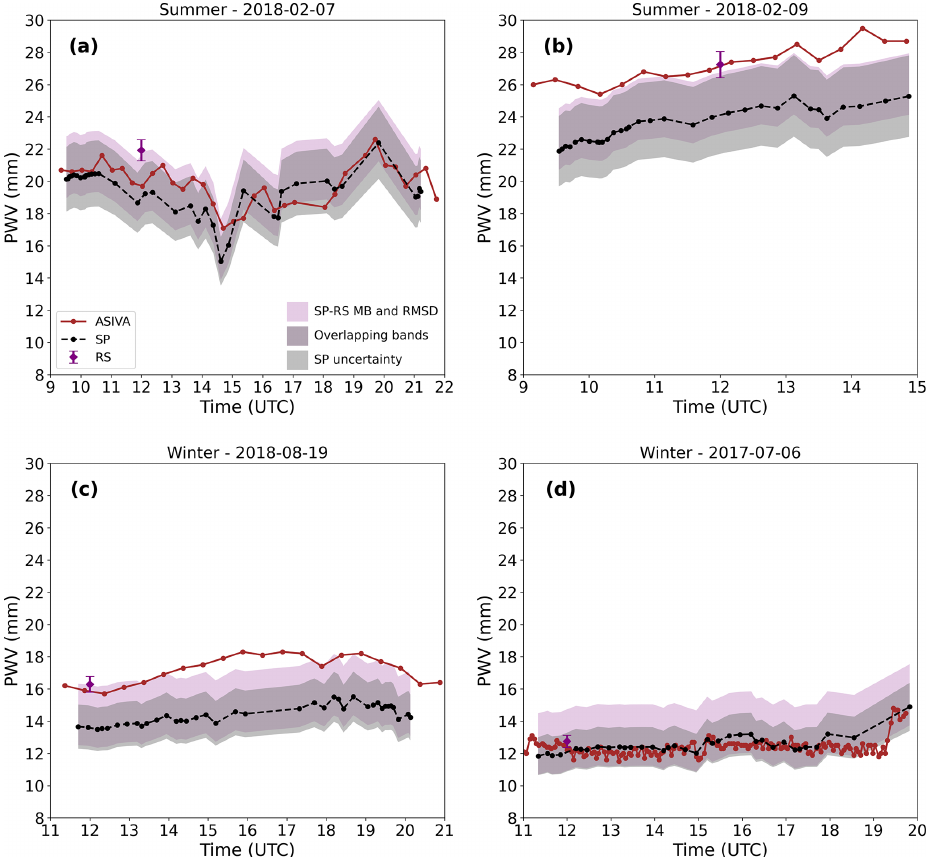
Figure 8. Examples of ASIVA PWV retrieval time series (brown) using specific 09:00LT (12:00UTC) radiosonde profiles for each case compared to AERONET (black) and radiosonde (purple) for two summer days, ( a ) 7 February 2018 and ( b ) 9 February 2018, and two winter days, ( c ) 19 August 2018 and ( d ) 6 July 2017. Shaded bands and radiosonde error bars are the same as in Fig.